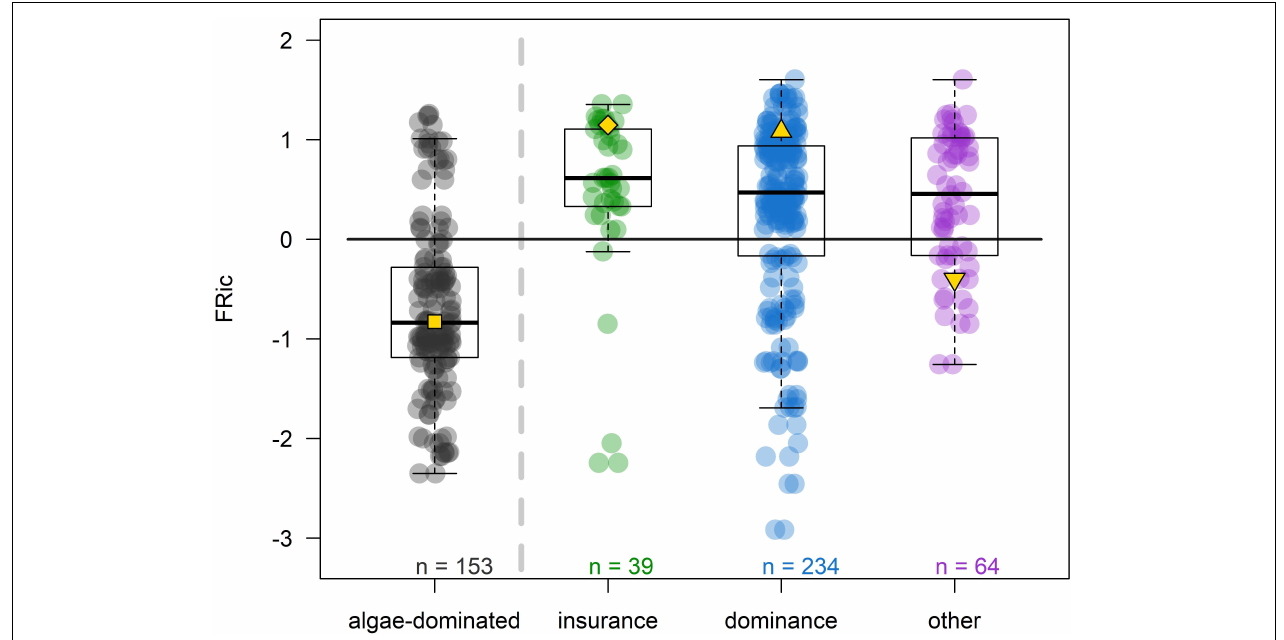
FIGURE 6 | Relationships between FRic and coral-dominance via the insurance or strong dominance effects for both scenarios (each dot represents a community in either the cyclone or bleaching scenario; total n = 2 × 245). Algae-dominated communities (black dots) have < 50% coral cover 10 years after the disturbance. Communities showing the insurance effect (green dots) are defined by having at least two morphologically complex species (i.e., tabular, digitate, corymbose, branching, and columnar) and a switch of dominance among these species and between just before the onset of the disturbance and 3 years after. Communities showing strong dominance effect (blue dots) are characterized by a constant dominance of the same morphologically complex species (i.e., just before the disturbance, 3 and 10 years after) and a relative % cover of at least 30% 10 years after the disturbance. The horizontal line shows the initial FRic averaged across all communities and scenarios. The prevalence of the positive selection effect is shown by the higher number of communities with strong dominance effect and above-average FRic . The yellow symbols designate the communities presented in Figure 7